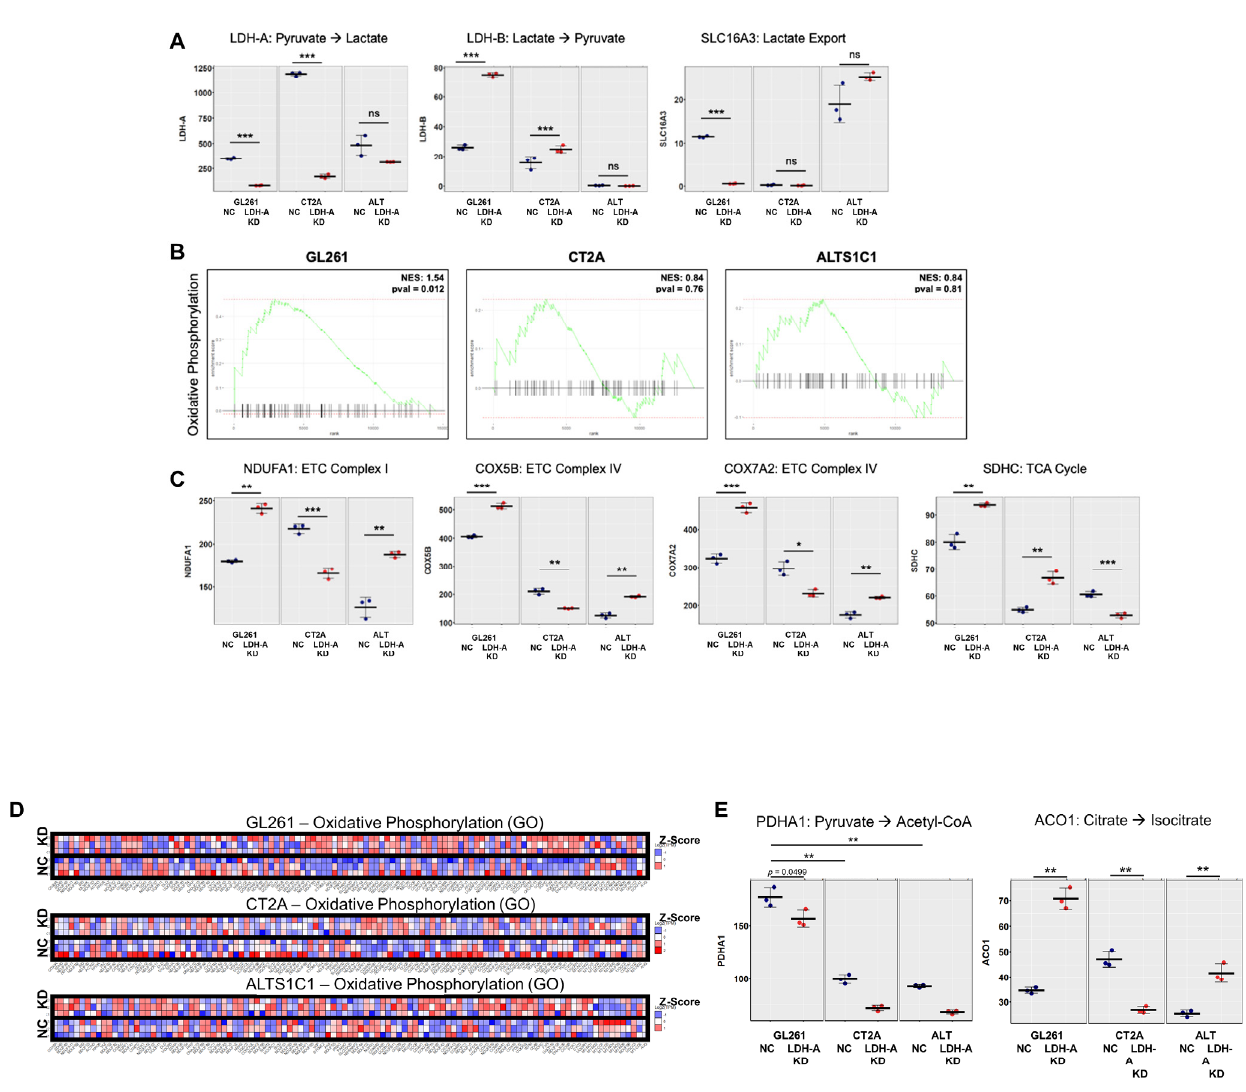
Figure 3. Overexpression of genes involved in oxidative phosphorylation in GL261 LDH-A KD cells. Transcripts per million (TPM) expression values were plotted in individual cell lines for genes directly involved in lactate metabolism and export (LDH-A, LDH-B, and SLC16A3) ( A ). Gene Set Enrichment Analysis (GSEA) for a single pathway (GO_OXIDATIVE_ PHOSPHORYLATION) is shown for each GBM cell line. The analysis shows the enrichment of this pathway in LDH-A- depleted vs. control cells ( B ). TPM values for enzymes involved in oxidative phosphorylation ( C ). The Z-transformed scores of individual genes within the oxidative phosphorylation (GO) pathway were plotted across each cell line (GL261, CT2A and ALTS1C1). The experiment was performed in triplicate, with rows representing each sample and columns representing individual genes ( D ). Expression (TPM) of pyruvate dehydrogenase alpha 1 (PDHA1) and aconitase 1 (ACO1) was plotted ( E ). PDHA1 is a nuclear-encoded mitochondrial matrix multienzyme complex that provides the primary link between glycolysis and the tricarboxylic acid (TCA) cycle by catalyzing the irreversible conversion of pyruvate into acetyl-CoA; ACO1 is a bifunctional, cytosolic protein that functions as an essential enzyme in the TCA cycle. Significant differences are indicated by: * p < 0.05, ** p < 0.01, and *** p < 0.001. Table S2 of the Supplement provides the semi-raw data from the RNASeq analysis that was used to generate the